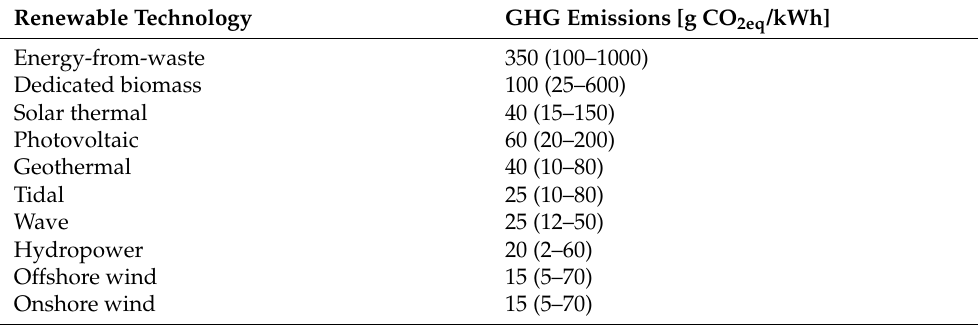
Table 2. GHG emissions of the different renewable energy sources